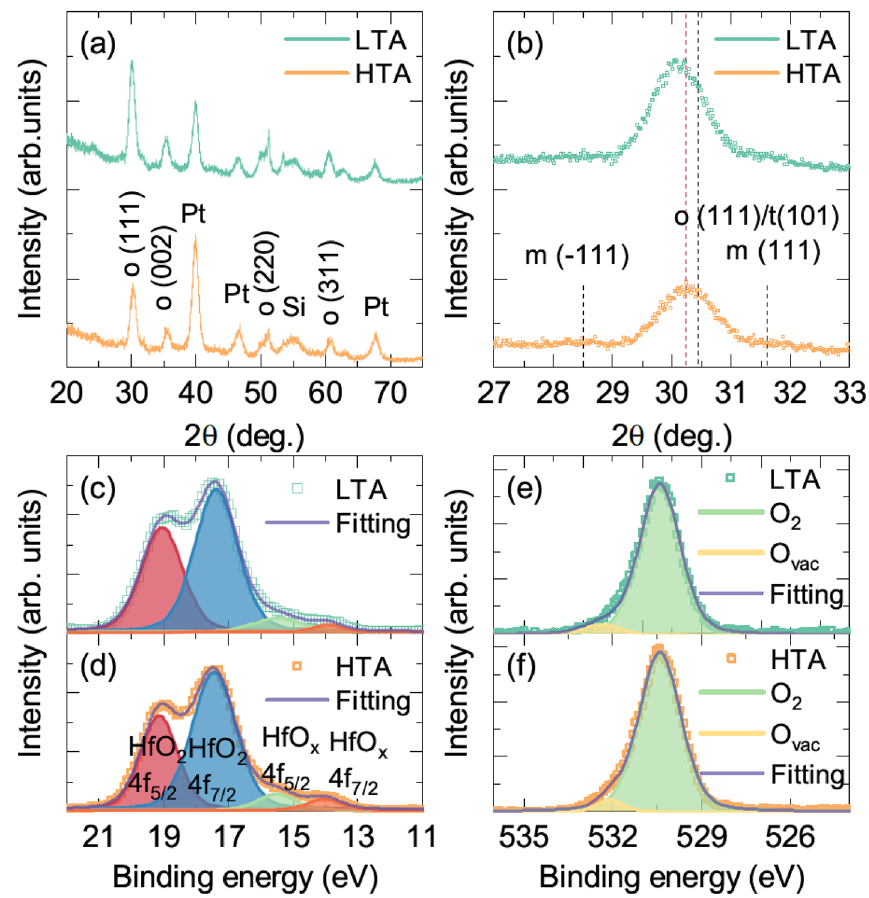
Figure 1. Structural and chemical analyses of HfO 2 films. ( a ) Grazing incidence X-ray diffraction (GIXRD) results after annealing at 600 °C for 20 s (LTA) and 800 °C for 1 s (HTA). ( b ) Enlarged GIXRD results near the orthorhombic (111) peaks. X-ray photoemission spectroscopy results near the Hf 4f peak for ( c ) LTA and ( d ) HTA films and O 1 s peak for ( e ) LTA and ( f ) HTA